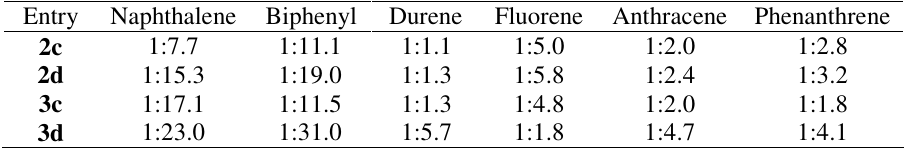
Table 1. Solubility ratio (Solubility in water: in presence of tweezer in water) of arenes in